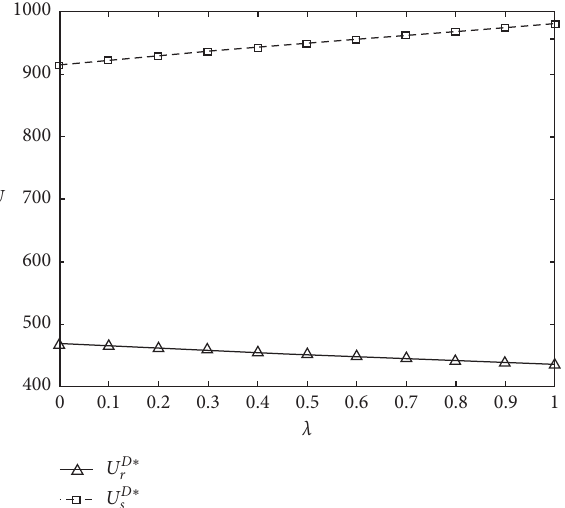
Figure 6: The effect of risk aversion coefficient on utility.